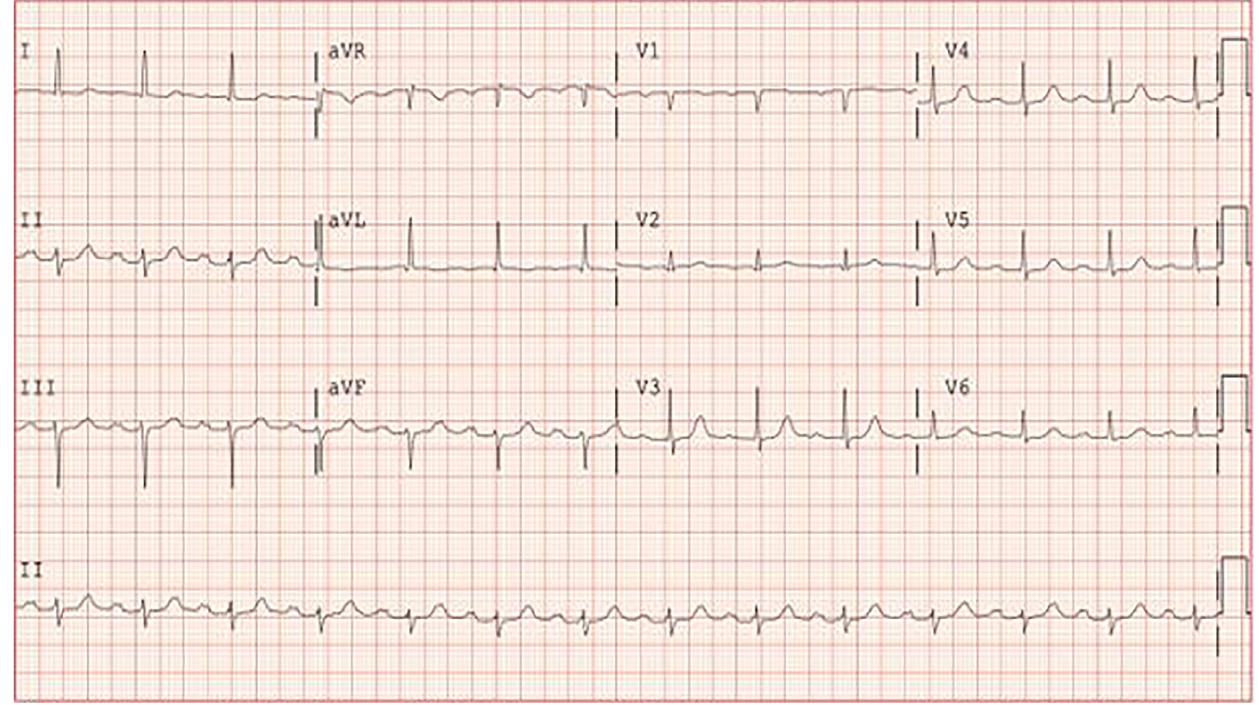
Image 2. Repeat electrocardiogram, demonstrating resolution of artifact after exchanging cardiac monitor